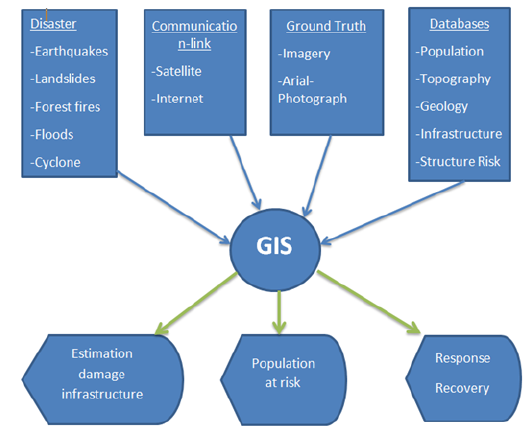
Figure 1. Figure GIS for Disaster Management 2. VOLUNTARY GEOGRAPHIC INFORMATION (VGI):